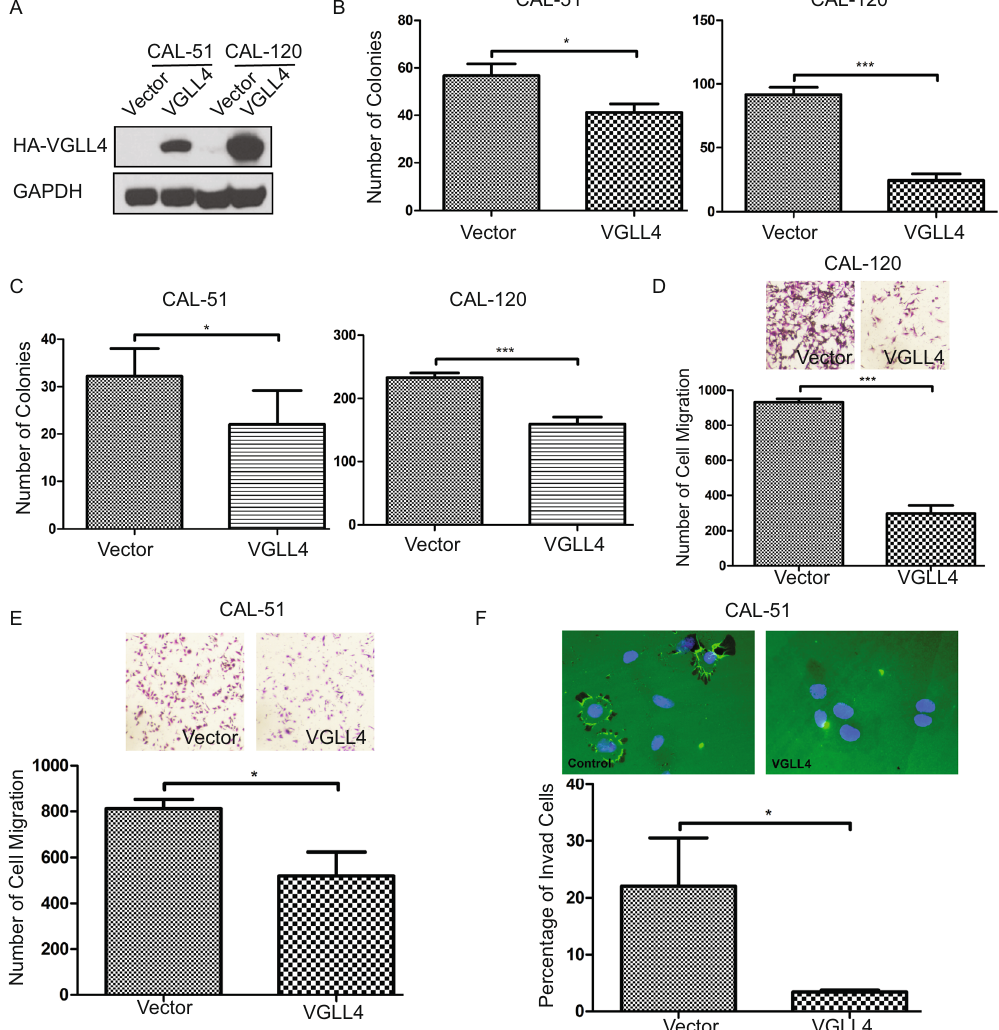
Figure 2. VGLL4 overexpression inhibits the proliferation, colony-formation and transformation abilities of breast cancer cells in vitro . ( A ) Immunoblot of ectopic VGLL4 expression in the CAL-51 and CAL-120 cells. Quantification of colony-formation ( B ) and anchorage-independent growth in soft agar ( C ) of vector- or VGLL4-transduced CAL-51 and CAL-120 cells. Representative migration images and quantification of cell migration of vector- or VGLL4-transduced CAL-120 ( D ) and CAL-51 cells ( E ). ( F ) Representative invasion images and quantification of cell invasion of vector- or VGLL4-transduced CAL-51 cells. ( * P < 0.05, ** P < 0.01, *** P <